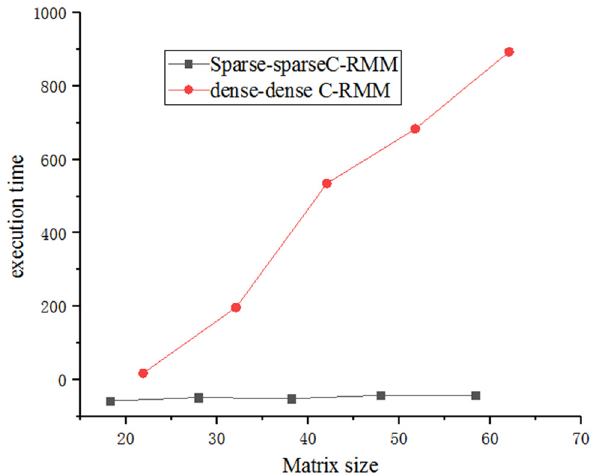
Figure 4: The performance of distributed sparse - sparse matrix multiplication varies with matrix dimensions.